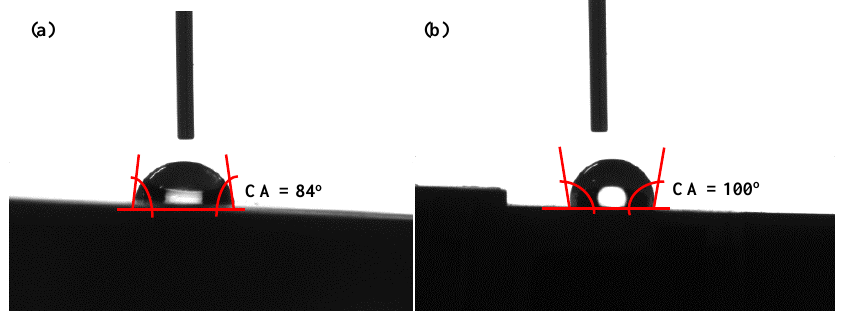
Figure 4. Water droplet contact angles on surface of PEI composite before ( a ) and after ( b ) sandblasting process.